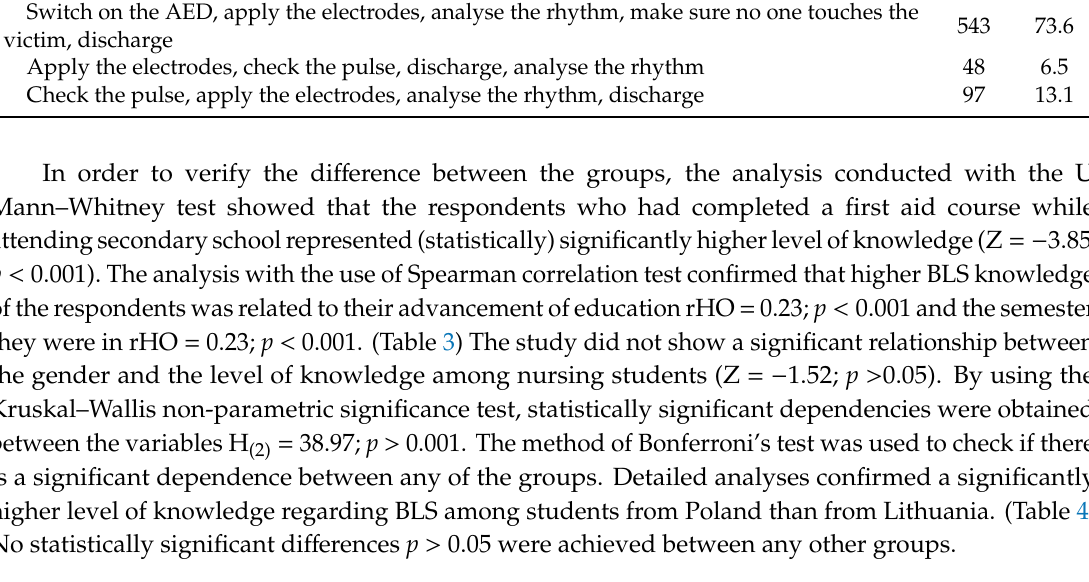
Table 3. Correlation between variables—The level of knowledge about basic life support (BLS) vs first aid